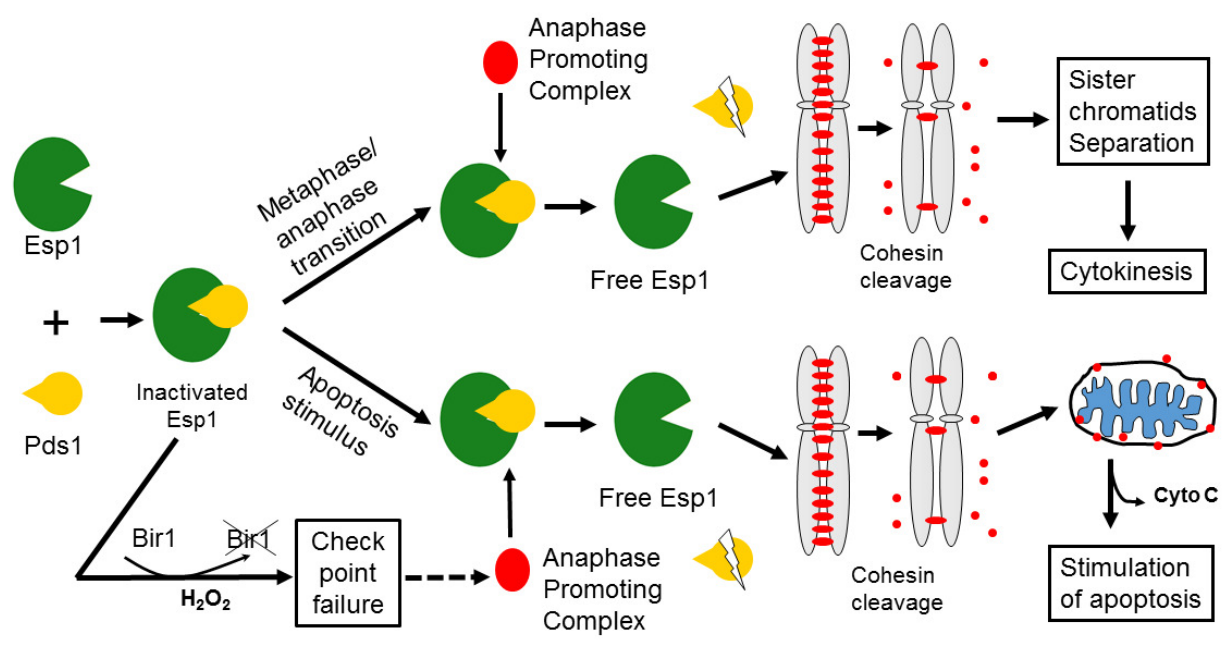
FIGURE 2: Involvement of essential genes (ESP1, MCD1 and BIR1) in apoptotic cell death. Modified according to